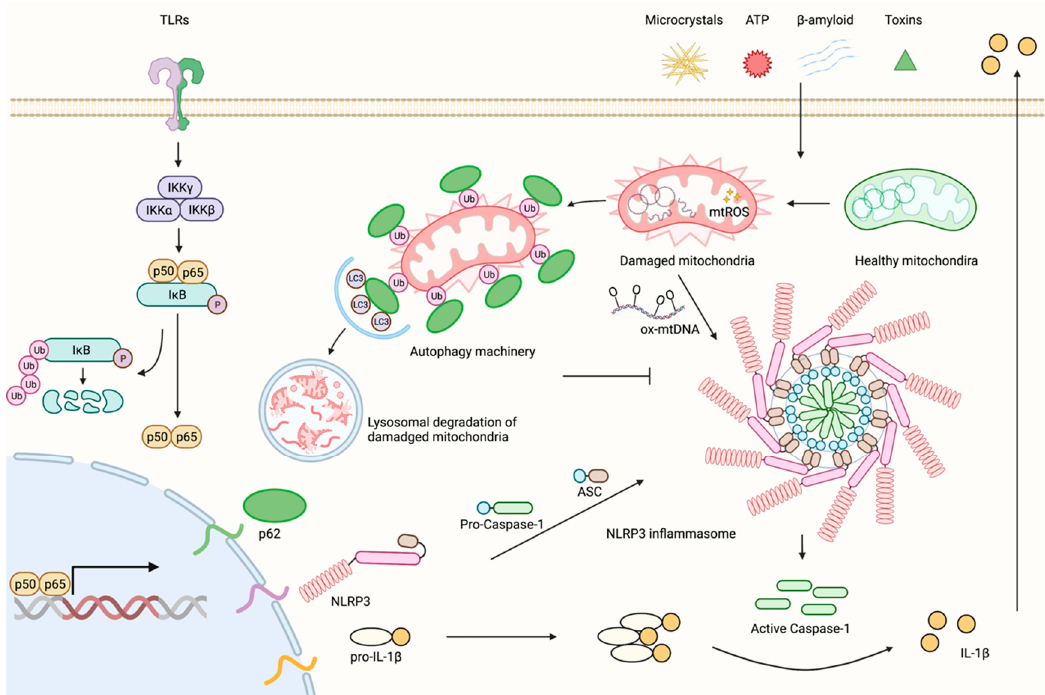
Figure 1. NF- κ B controls both the gas pedal and brake of the NLRP3 inflammasome. During inflammasome priming, TLR activation results in NF- κ B-dependent robust transcriptional upregulation of NLRP3 and de novo synthesis of pro-IL-1 β . In parallel, NF- κ B activation also induces p62 upregulation, although with slower kinetics. In the inflammasome activation step, various NLRP3 inflammasome activators trigger mitochondrial damage, resulting in the generation of oxidized mtDNA (ox-mtDNA), which is subsequently released from the damaged mitochondria to the cytosol, where it binds to and activates NLRP3. This leads to the assembly of the inflammasome complex, followed by autocleavage and activation of caspase-1, which in turn proteolytically processes pro-IL-1 β into its mature and bioactive form, thereby igniting inflammation. Meanwhile, to prevent NLRP3 overactivation, p62 induced upon NF- κ B activation promotes the autophagic degradation of the damaged mitochondria, a process also known as mitophagy, and thereby restricts NLRP3 hyperactivation. In summary, NF- κ B controls both the gas pedal and brake of NLRP3 inflammasome to generate a well-balanced immune response that focuses on the removal of insults and tissue repair while avoiding immunopathology (the figure was created using BioRender).